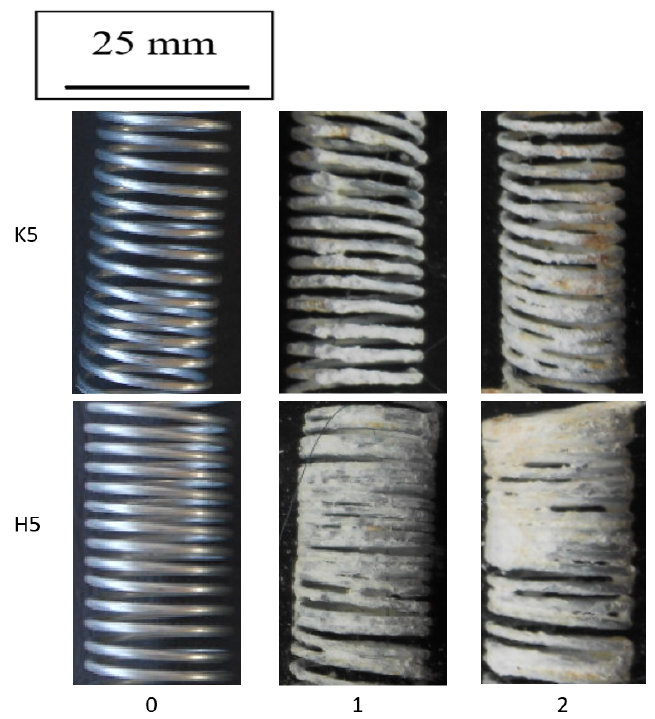
Figure 10. The surface appearance of the wires drawn at a speed of 5 m/s using the conventional K5 and hydrodynamic H5 method during corrosion tests in a salt chamber after two test cycles.